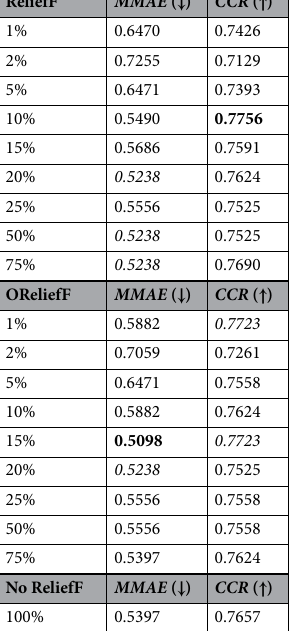
Table 1. OReliefF versus ReliefF comparison in terms of CCR and MMAE obtained by the ordinal classifier without the application of data augmentation (5-fold cross validation results). The best results are shown in bold. The second best results are shown in